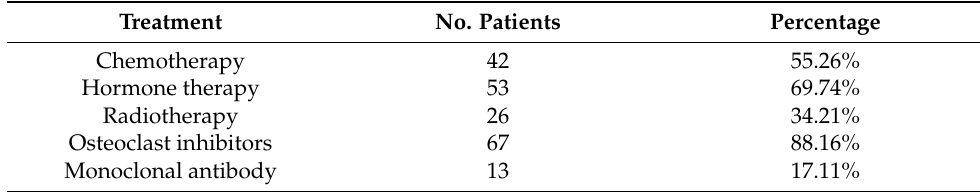
Table 1. Treatment data of the patients included in the study. Treatment No.